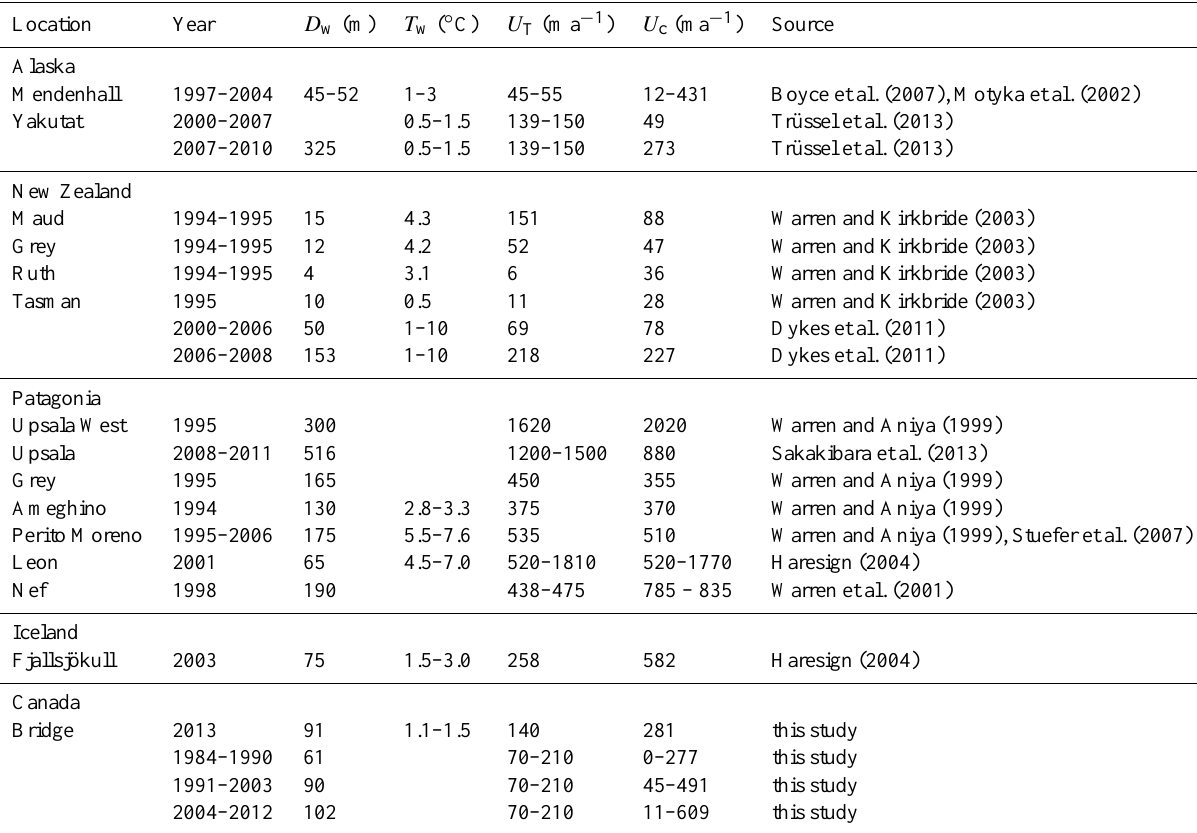
Table 2. Characteristics of selected major lake-calving glaciers worldwide. D w is the mean water depth, T w is the mean water temperature (depth averaged or interannual range), U T is the terminus averaged flow speed, and U c is the calving rate.